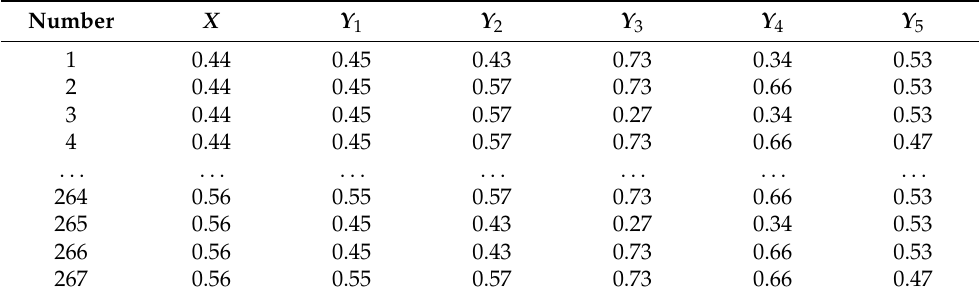
Table A3. Quantitative results of experimental data in study